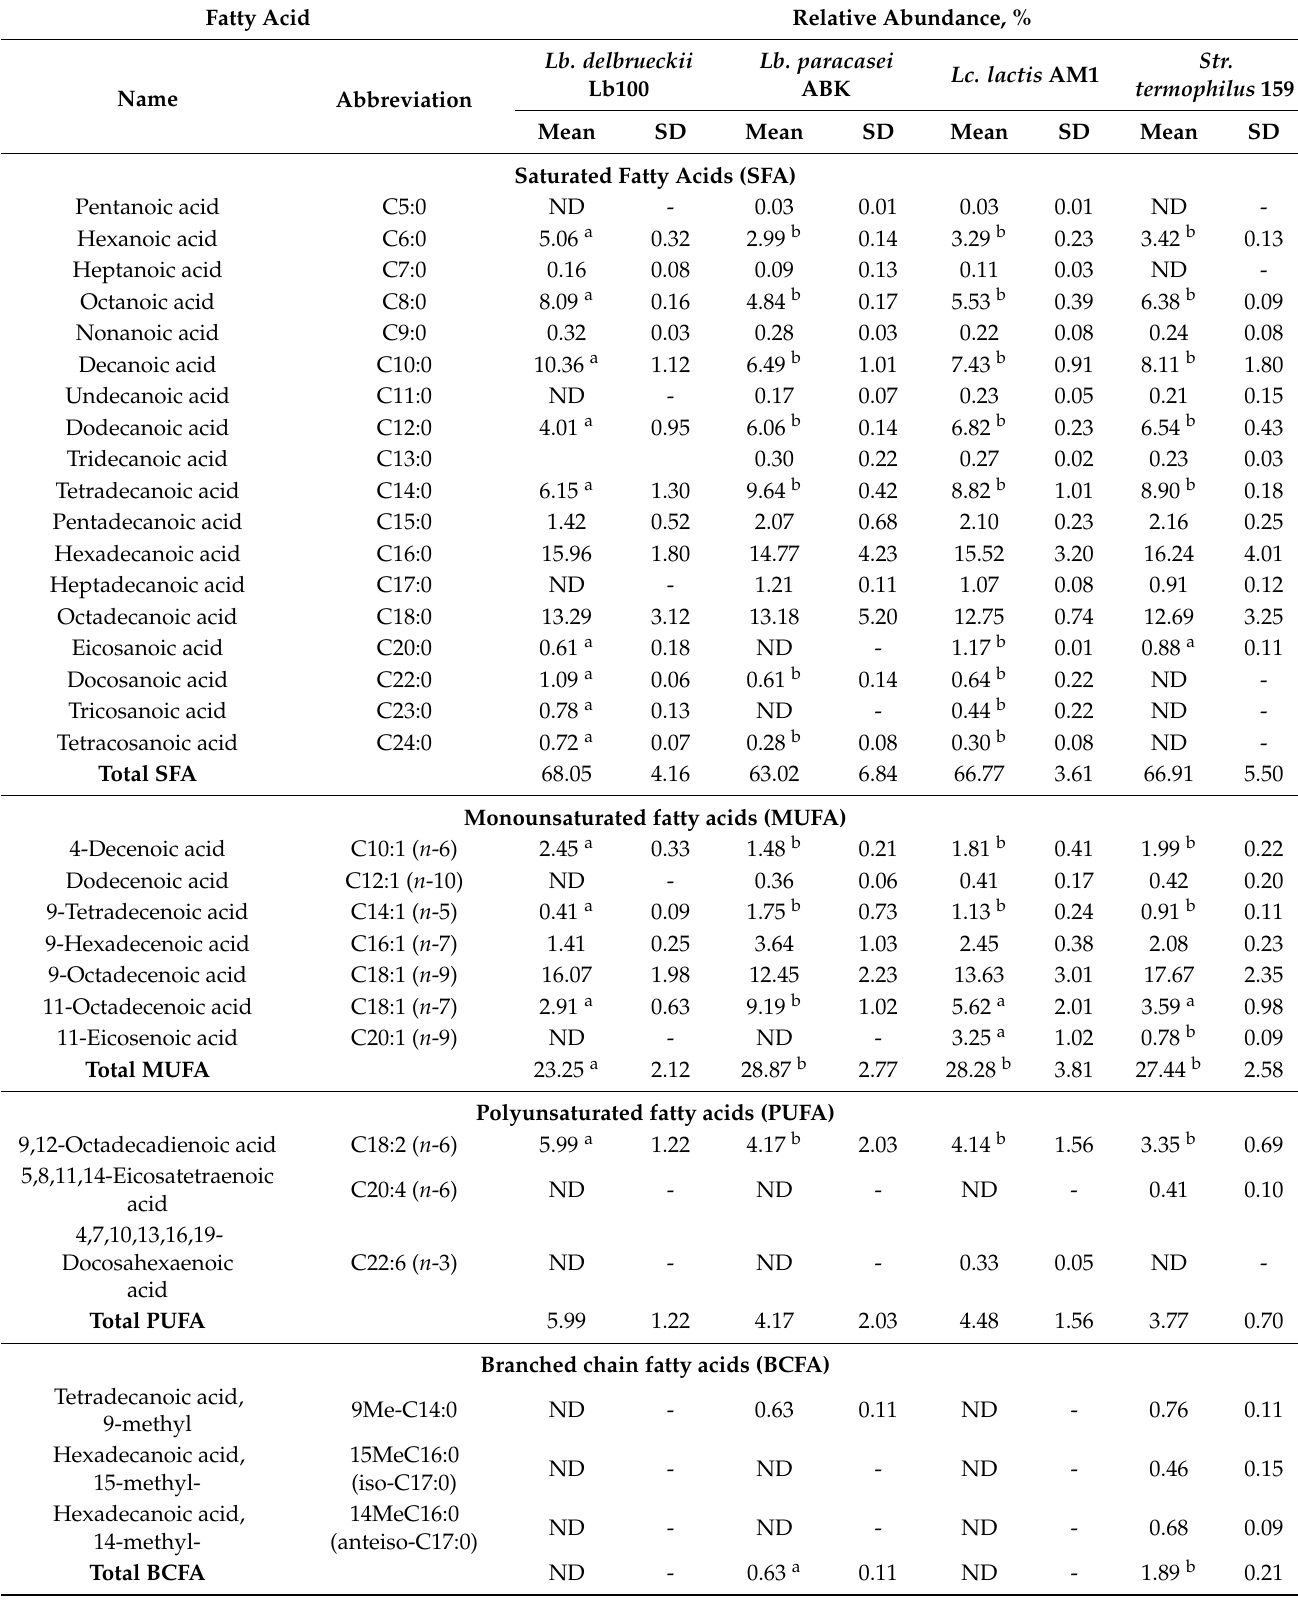
Table 2. Fatty acids (FA) composition of the milk fermented by the chosen strains of lactic acid bacteria. Fatty Acid Relative Abundance,